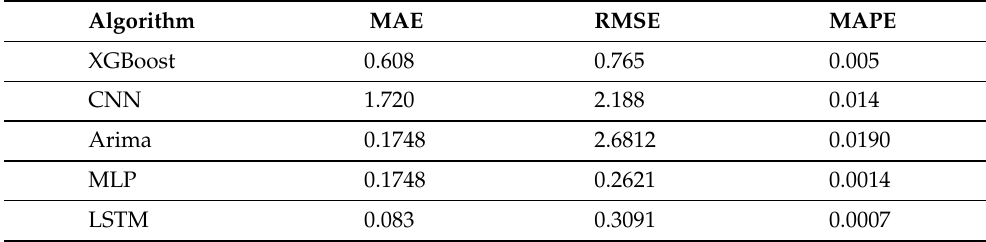
Table 3. Statistical testing